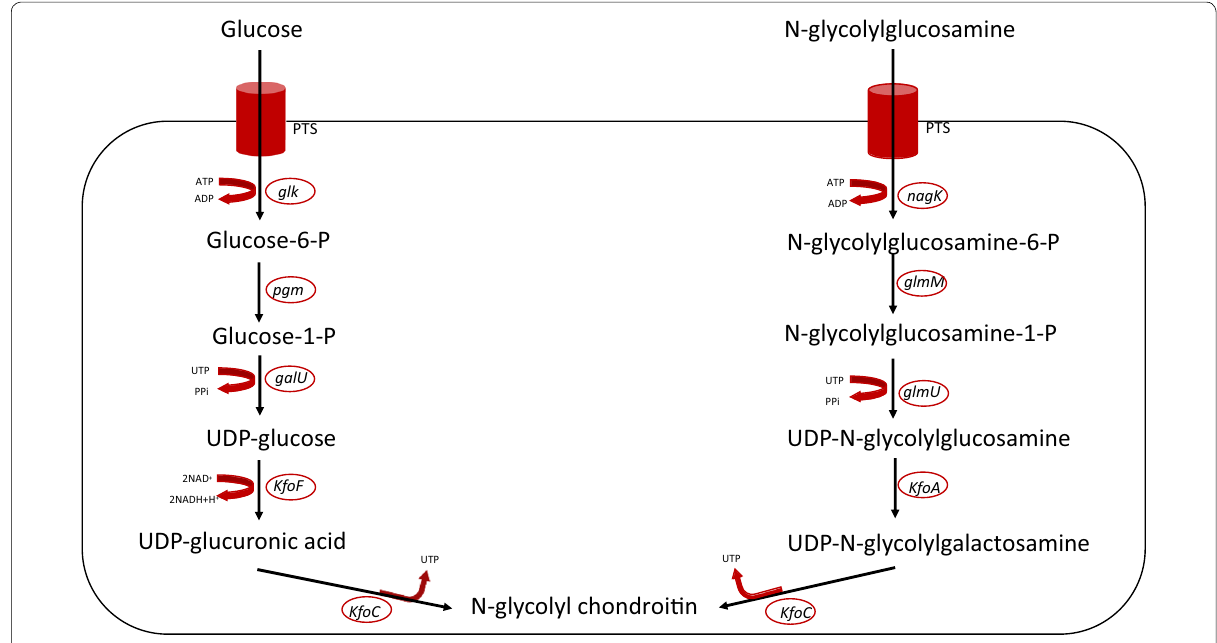
Fig. 5 Metabolic pathway for N -glycolyl chondroitin synthesis in E. coli